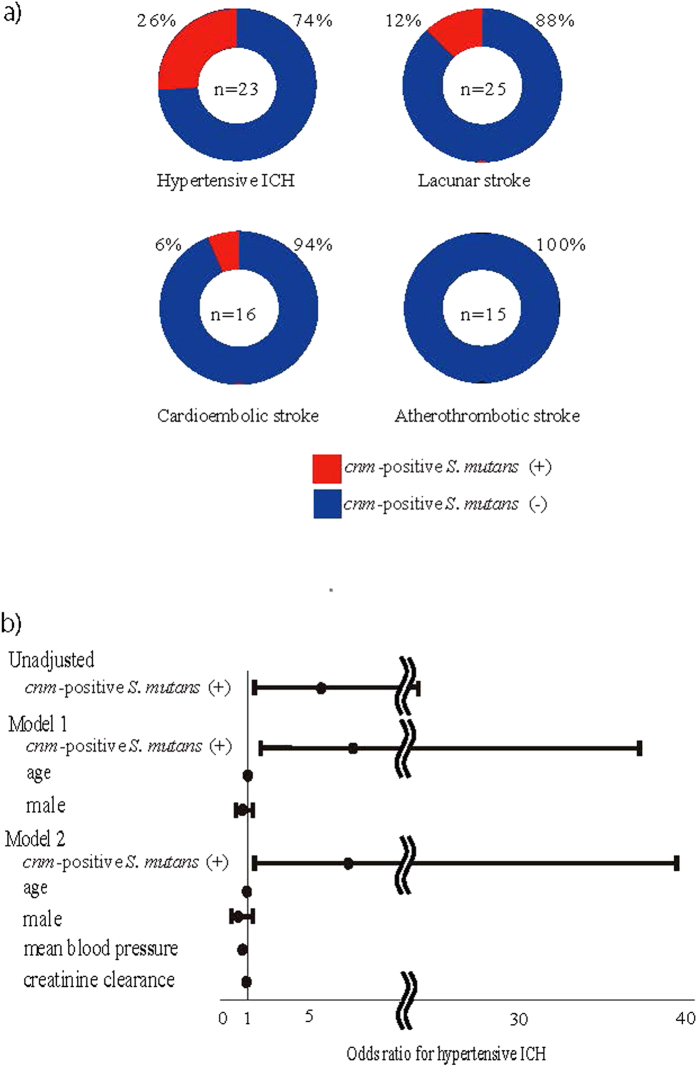
Association of cnm-positive S. mutans with ICH.(a) cnm-positive S. mutans was detected in 26% of hypertensive intracerebral hemorrhage and 12% of lacunar stroke but in only 6% of cardioembolic stroke and none of atherosclerotic stroke. The odds ratio of cnm-positive S. mutans in hypertensive ICH versus the other stroke subtypes was 5.56. (b) cnm-positive S. mutans was associated with hypertensive ICH before and after adjusted for established risk factors for ICH, such as age, sex, mean blood pressure and creatinine clearance. Error bars show 95% confidence interval. ICH indicates intracerebral hemorrhage; S. mutans, Streptococcus mutans.